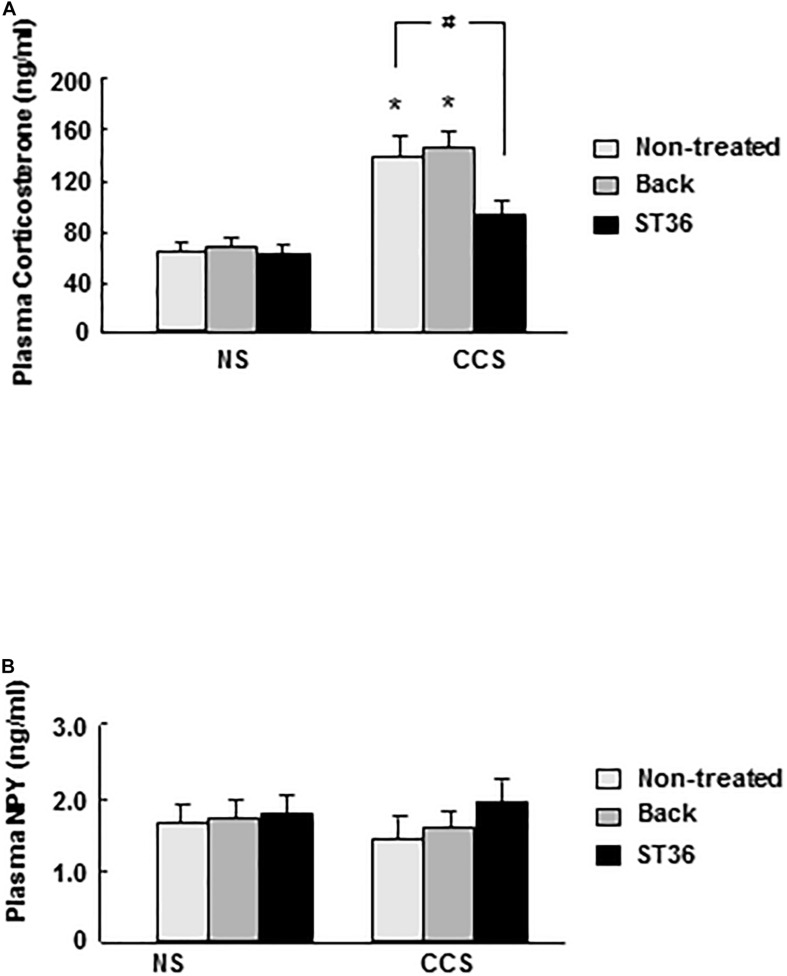
Effects of EA on serum corticosterone (A) and NPY (B) levels in response to CCS. (A) In the non-stressed (NS) groups, both EA at back and at ST-36 had no effect on the corticosterone level. In the CCS groups, corticosterone level increased significantly (non-treated). EA at back did not change the corticosterone level significantly, however, EA at ST-36 significantly decreased the corticosterone level. (B) In the non-stressed (NS) groups, both EA at back and at ST-36 had no effect on the NPY level. In the CCS groups, NPY level decreased, but not shown significantly changed (non-treated). Both EA at back and EA at ST-36 also did not change the NPY level significantly (n = 6, *P < 0.05 compared with NS non-treated group, #P < 0.05 compared with CCS non-treated group).